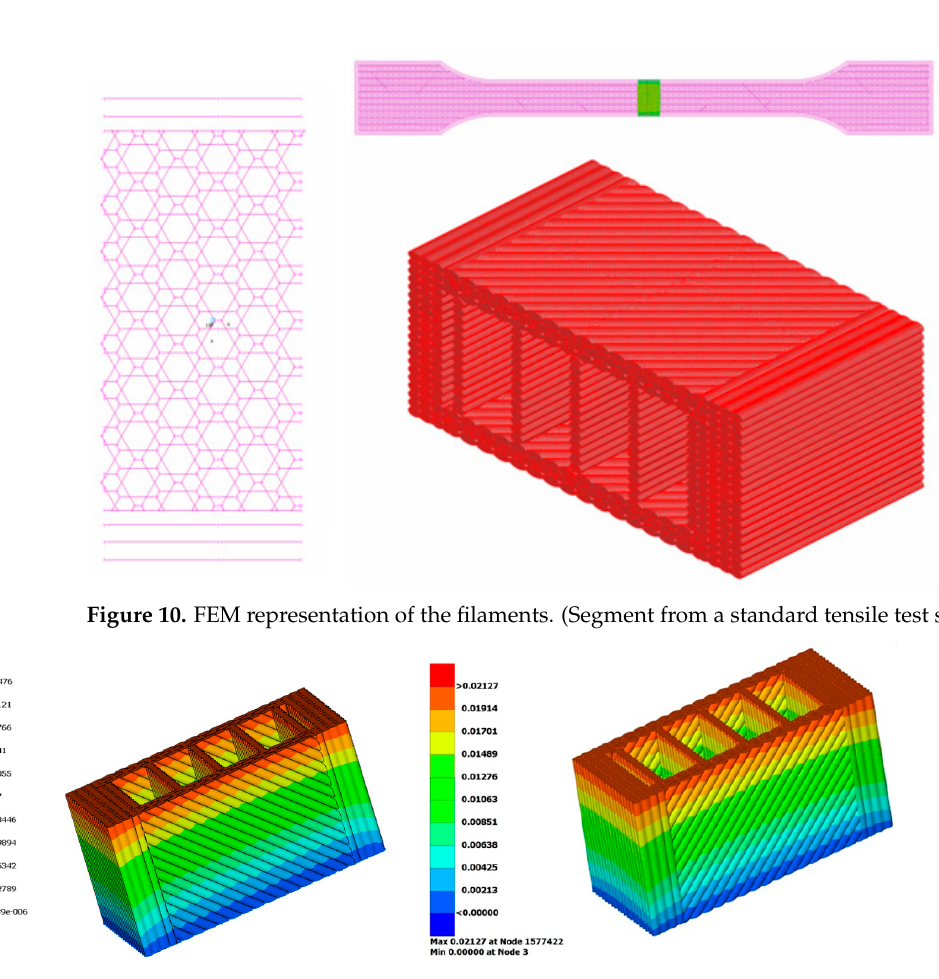
Figure 11. Result of simulation in: ( a ) Epilysis and in ( b ) Nastran.